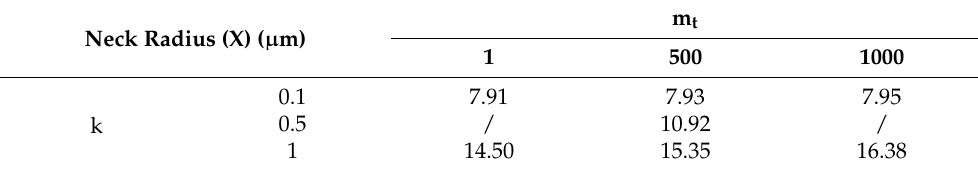
Table 8. Neck radius obtained from simulations of set 1, set 2, and set 3 of Table 3. Table 9. Neck radius obtained from simulations of set 4 from Table 3.